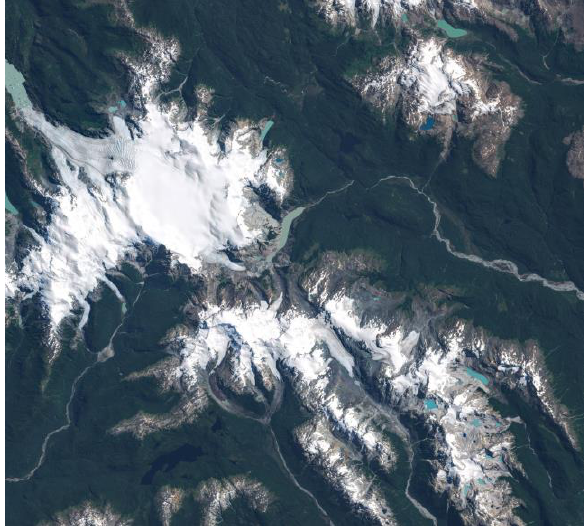
Figure 7: LuxCarta produced 8bit True Color Image.